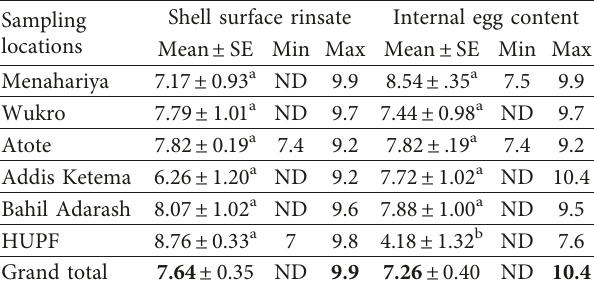
Table 5: Staphylococcal count (SC) in log surface rinsates and contents of egg samples in Hawassa City, southern Ethiopia, 2019.